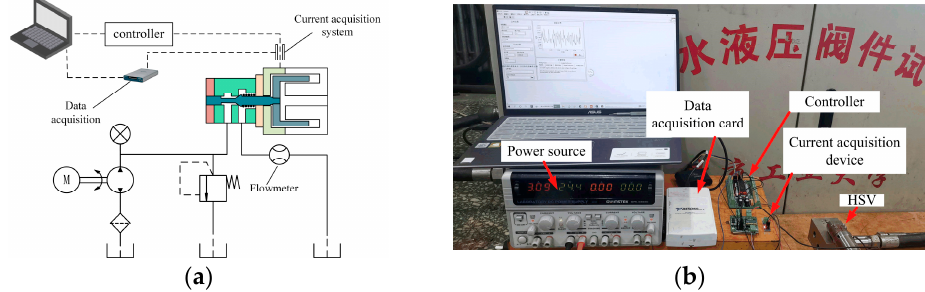
Figure 6. Experimental system for current detection. ( a ) Schematic diagram. ( b ) HSV test bench.